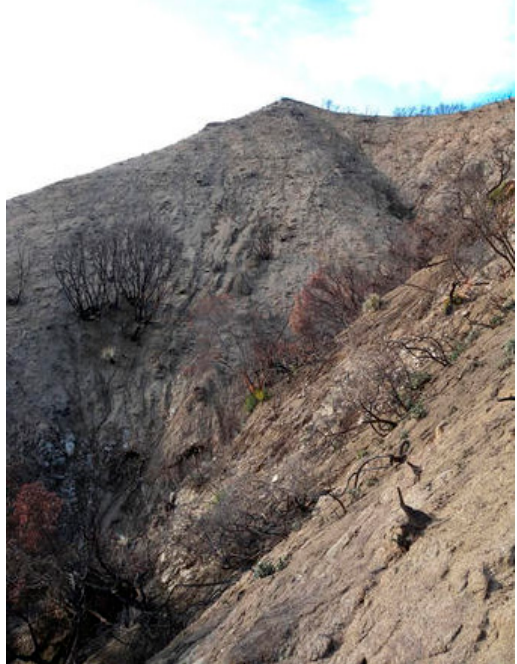
Figure 4. Burned hillslopes at the Arroyo Seco watershed in the 2009 Station Fire, CA.